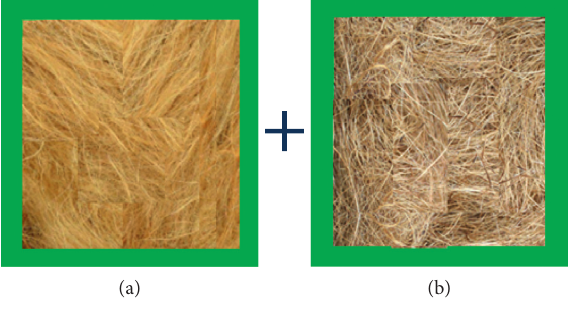
Figure 1: Natural fibers: (a) ramie fiber and (b) abaca